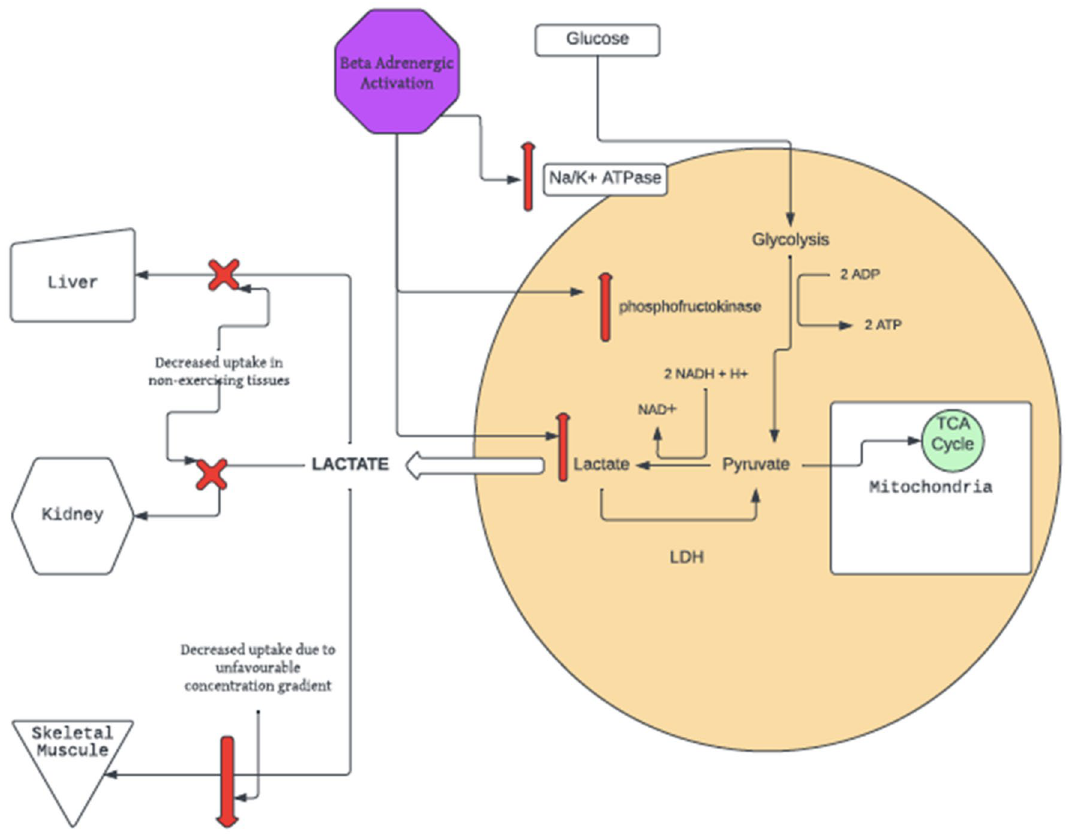
Figure 1. The proposed effect of beta adrenergic stimulation on lactate